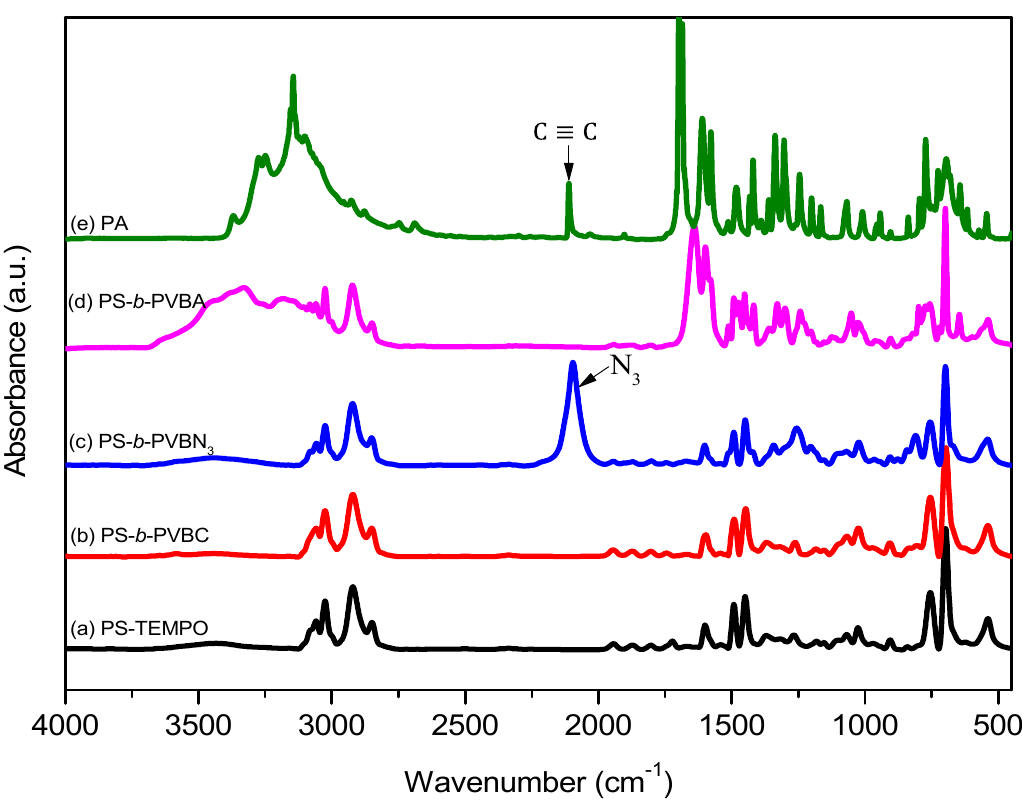
Figure 3. FTIR spectra of ( a ) PS-TEMPO; ( b ) PS- b -PVBC; ( c ) PS- b -PVBN 3 ; ( d ) PS- b -PVBA and ( e ) PA.